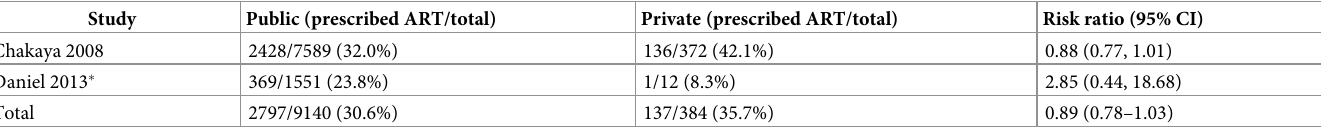
Table 2. HIV-TB co-infected patients prescribed antiretroviral therapy by